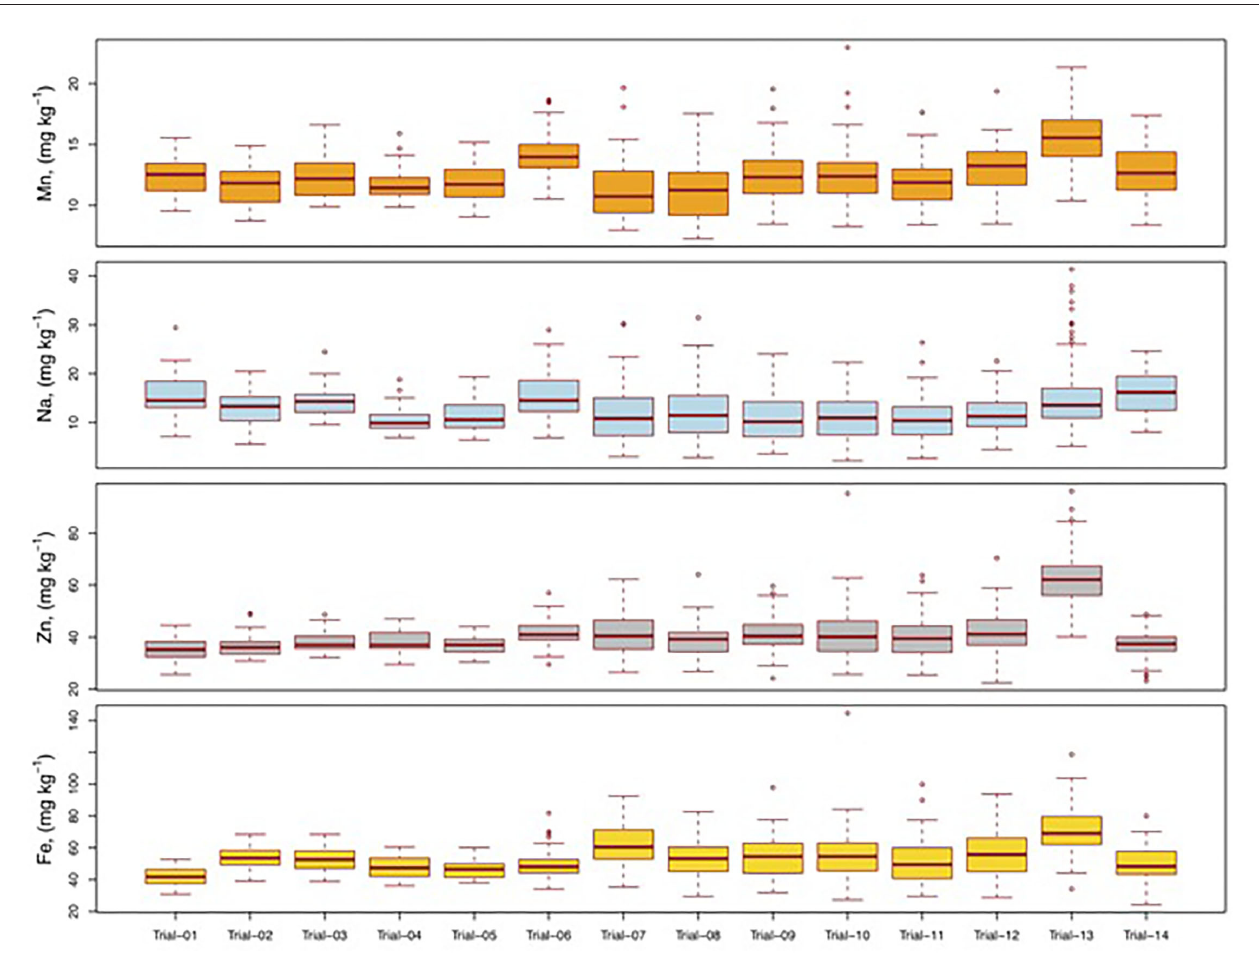
FIGURE 2 | Variability for iron (Fe), zinc (Zn), sodium (Na), and manganese (Mn) in pearl millet hybrid trials (trial 1 to trial 6), inbred trials (trial 7 to trial 12 and trial 14), and germplasm accessions (trial 13) at the ICRISAT, Hyderabad, India.